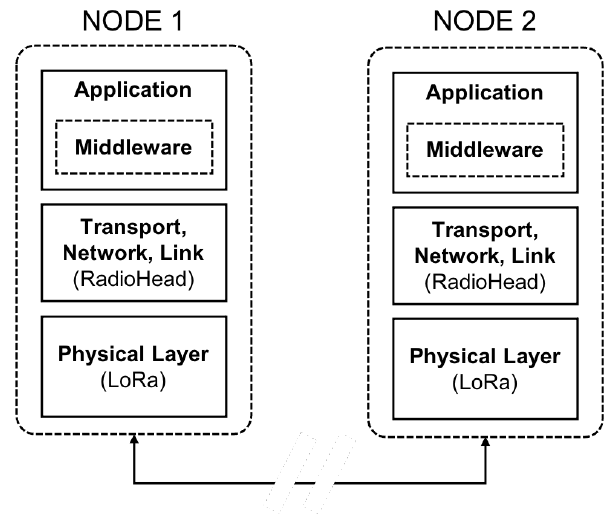
Figure 1. Proposed LoRa-based stack for peer-to-peer communication.